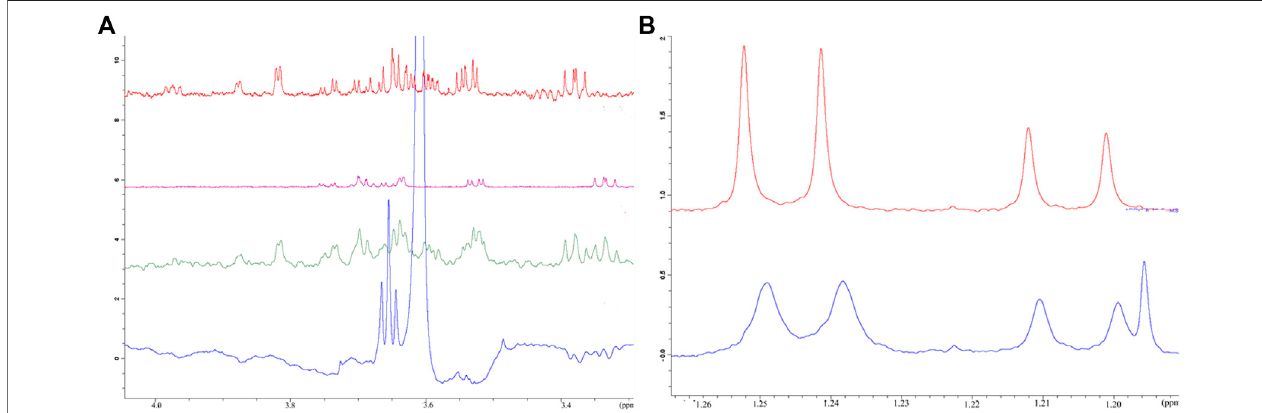
FIGURE 2 | Af fi nity of selected monosaccharides to riproximin by NMR spectroscopy. (A) Reveals the binding of galactose and fucose to Rpx as evaluated by waterLOGSY NMR spectra. Control experiments, i.e. in the absence of Rpx, are represented by galactose (red trace), fucose (pink trace) and both sugars (green trace) together. The waterLOGSY spectrum in blue shows the negative resonances for the ring protons of galactose and fucose in the presence of Rpx, thus indicating the binding of these sugars to Rpx. (B) Represents the binding of l-fucose to Rpx as demonstrated by line broadening in the 1 H NMR spectrum. The methyl doublet signals of L -fucose show clear line broadening due to binding to Rpx (bottom trace in blue). The more intense lines of the doublet at 1.25 ppm of the β -anomer are broadened toagreater extent than thelines ofthe doublet at 1.21 ppmofthe α -anomer, therebyindicatinggreater af fi nity ofthe β -anomertoRpx. Acontrol spectrum is also presented (top trace in red) (N.b. The additional line in the spectrum with Rpx is from ethanol).